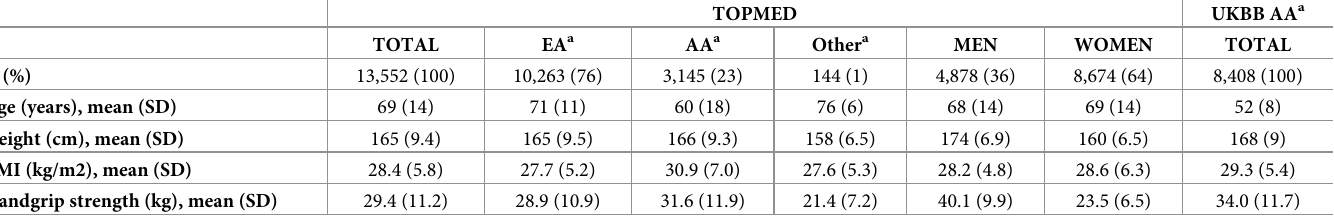
Handgrip strength (kg), mean (SD)